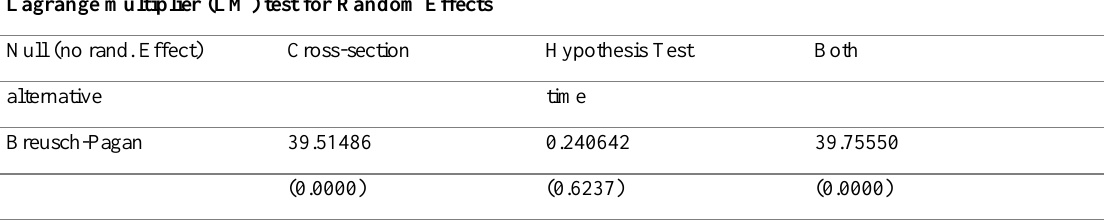
Table 7: Lagrange multiplier test output